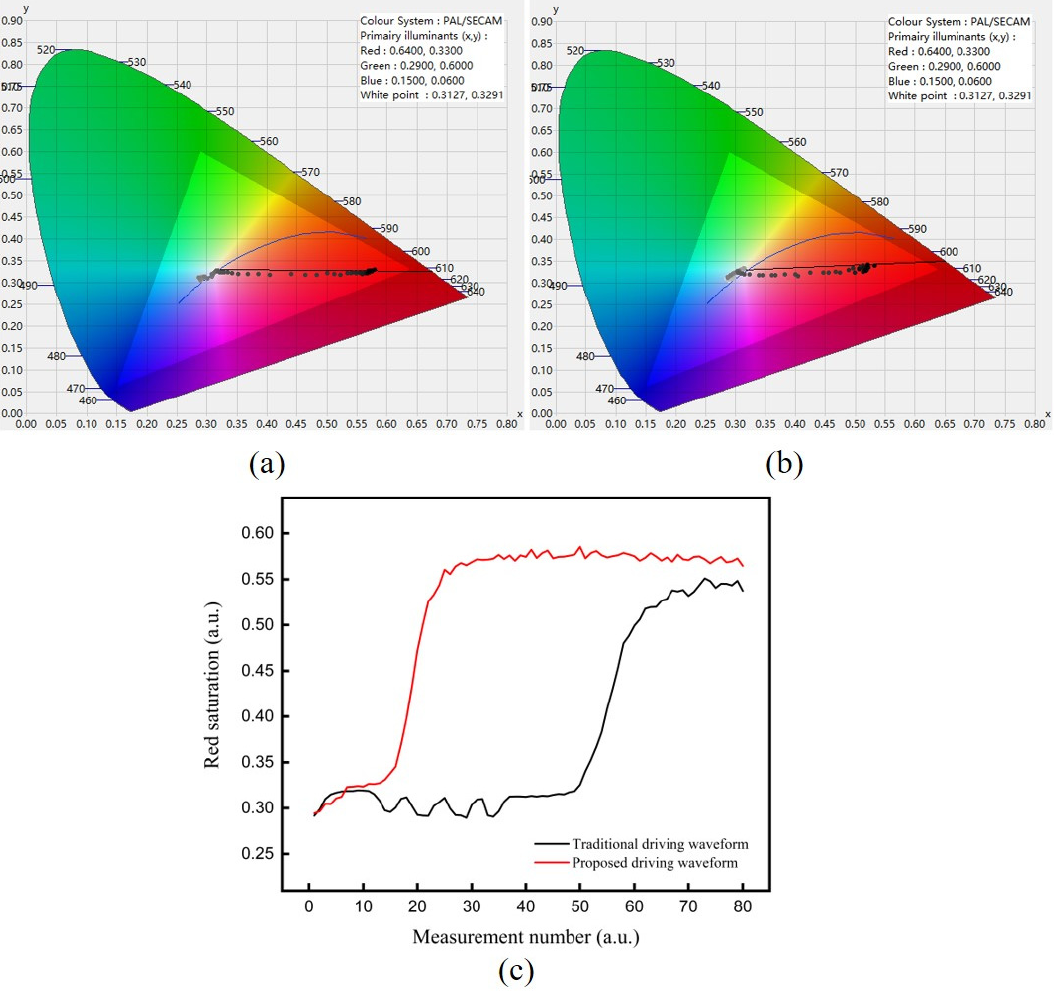
Figure 10. The red saturation when the three-color EPD was driven by the proposed driving waveform and the tradition driving waveform. ( a ) The red saturation of the three-color EPD achieved by the tradition driving waveform. ( b ) The red saturation of the three-color EPD achieved by the proposed driving waveform. ( c ) The comparison of the response time between the proposed driving waveform and the tradition driving waveform.